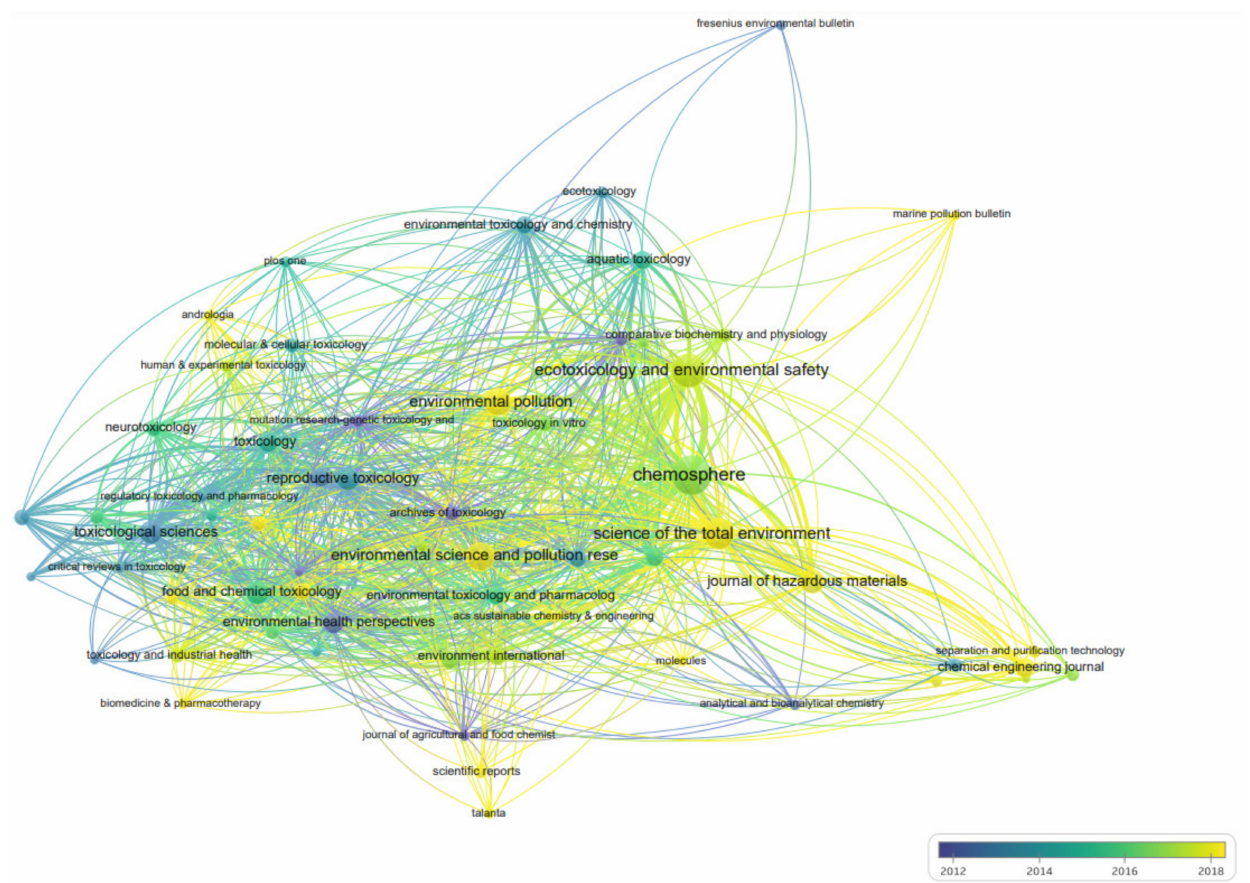
Figure 5. Journal distribution of “BPA toxicity” literature according to citation